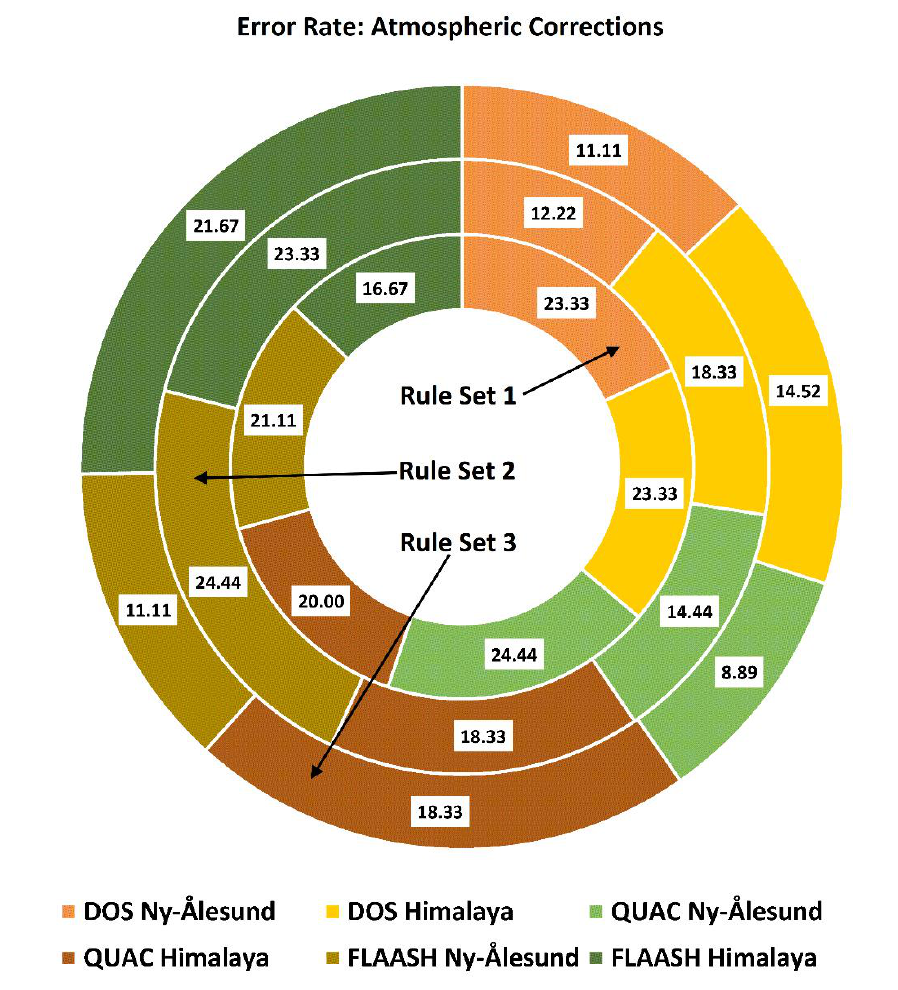
Figure 8. Error rates (in %) of the rule sets for the atmospheric corrections presented as a donut diagram. Inner circle: rule set 1, middle circle: rule set 2, and outer circle: rule set 3. Rule set 3 delivers the most consistent performance, i.e., the lowest error rate except